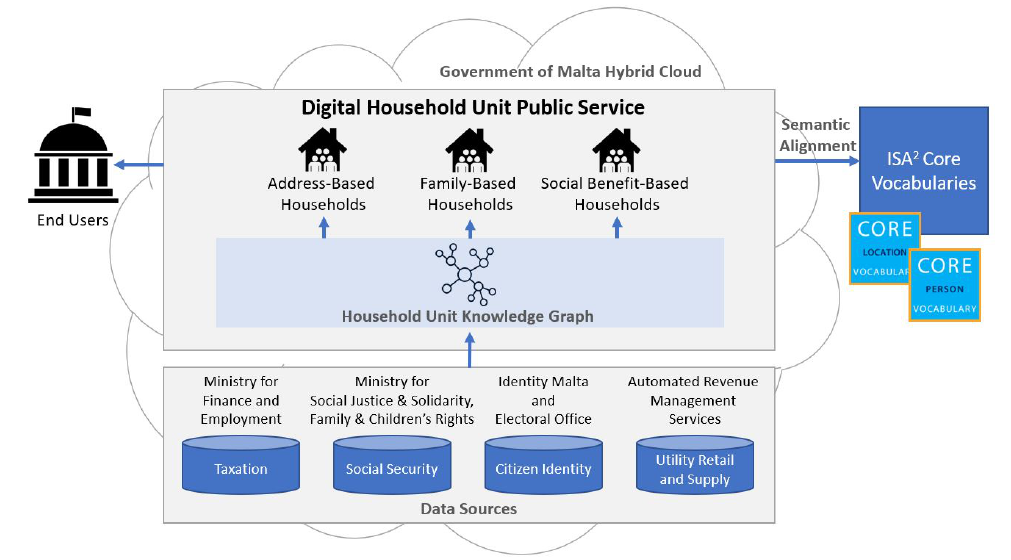
Figure 2. Digital common household unit IPS high-level